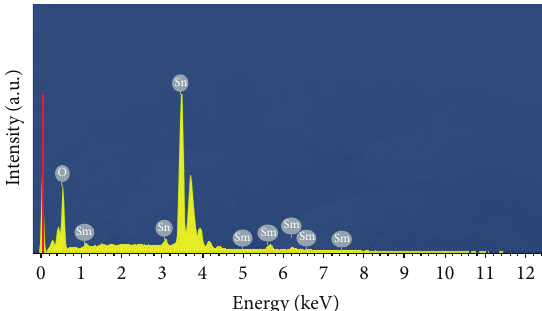
Figure 4: EDS spectrum of Sm 2 O 3 decorated SnO 2 nanostructures.